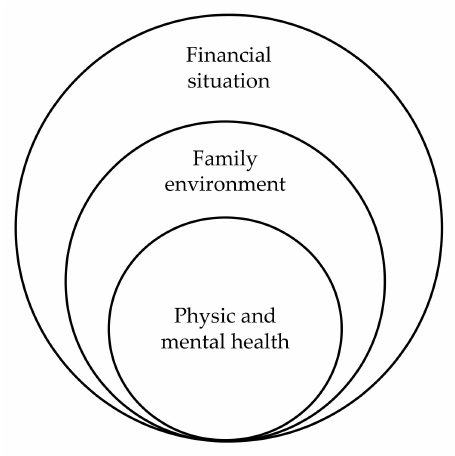
Figure 2. Key elements for life quality in older